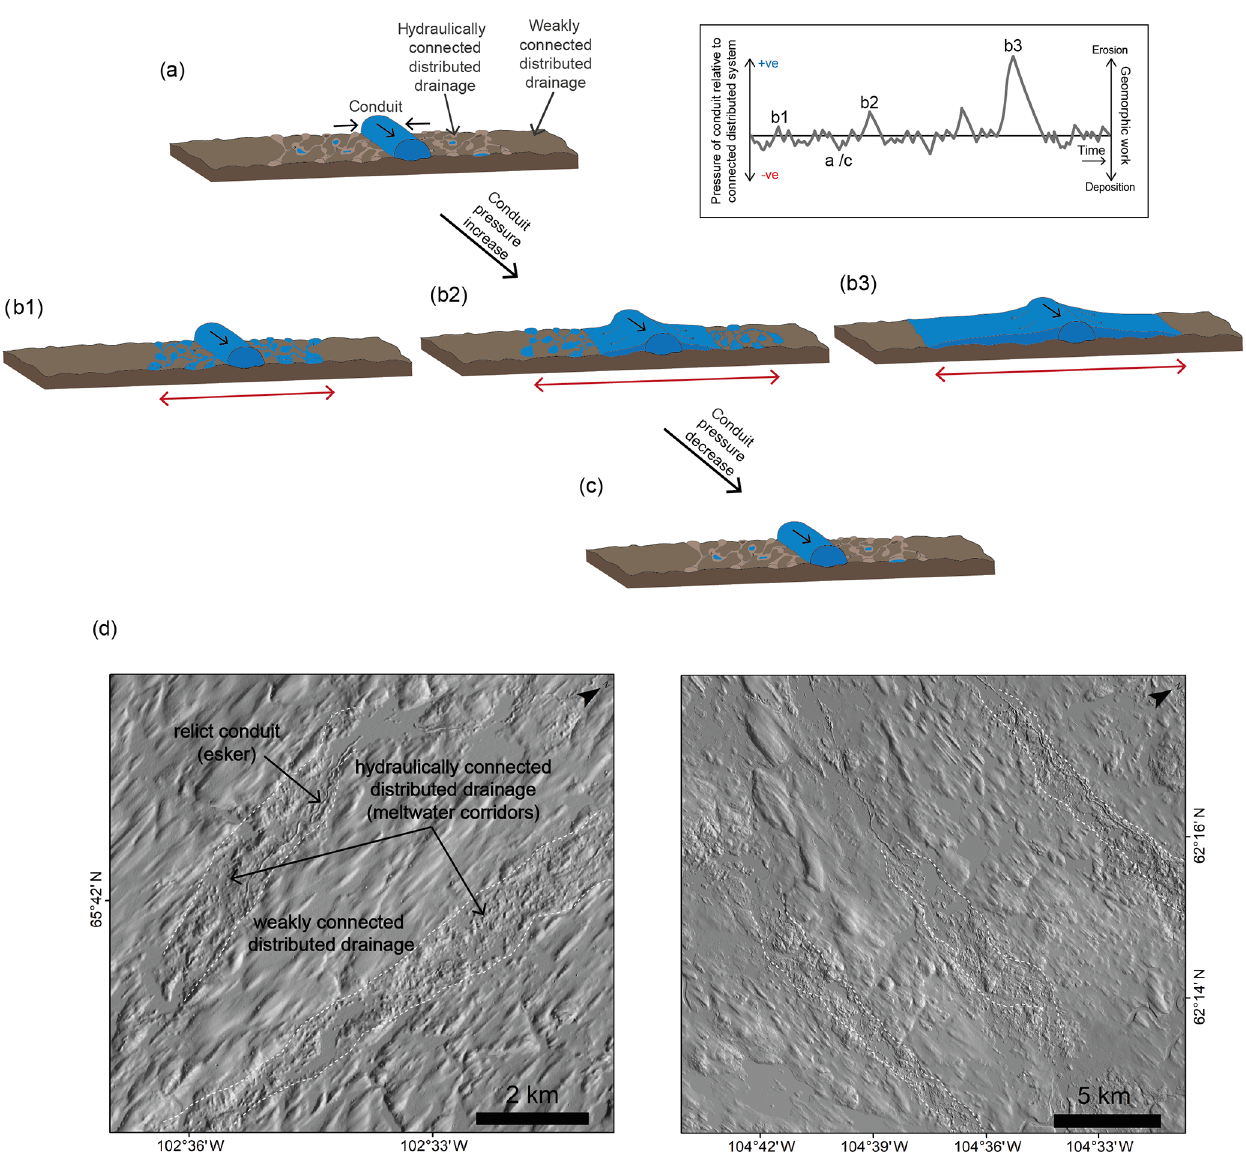
Figure 14. Effects of pressure perturbations on the hydraulic conductivity within the conduit connected distributed subsystem: (a) steady state – water is drawn in from across the connected distributed system into the conduit (low pressure) down the pressure gradient, and geomorphic work is limited to the conduit, although there may be some lateral sapping (e.g. Boulton and Hindmarsh, 1987); (b) during overpressurisation events water is forced out of the conduit across and into the surrounding hydraulically connected distributed drainage system. The width and form (i.e. flood or cavity expansion) this takes likely depends on the magnitude of the pressure perturbation. Geomorphic work (erosion and deposition) likely occurs during this phase; (c) return to steady state as meltwater input decreases or the conduit expands to accommodate a sustained increase in input; (d) proposed cumulative geomorphic imprint of the process over time, creating the meltwater corridors (white dashed lines) preserved on the landscape today. The inset in the upper-right corner demonstrates that pressure perturbations within the conduit fluctuate throughout the melt season and vary in size from regular diurnal fluctuations (e.g. b1 ) to irregular larger events (e.g. b2 and b3 ), which may represent precipitation or supra/subglacial lake